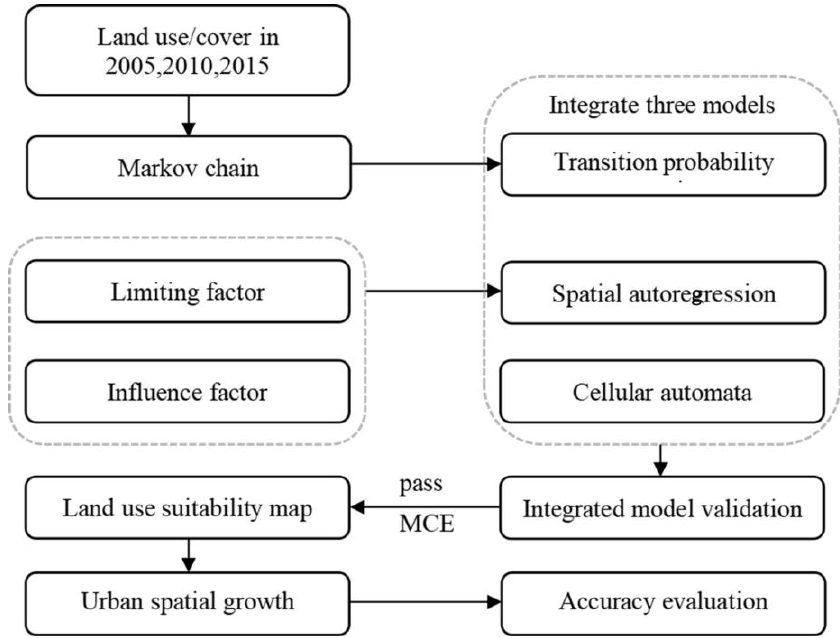
Figure 5. The framework of the optimized simulation process.